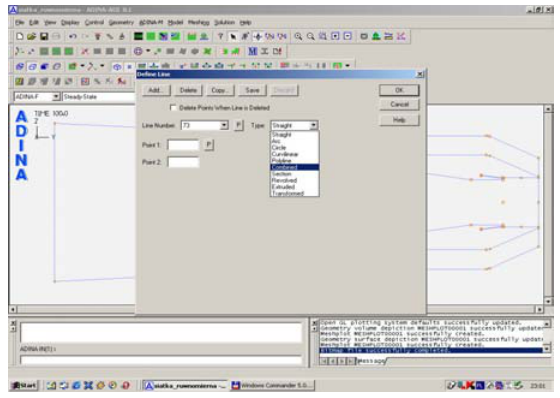
Fig 3. Different methods of defining surfaces